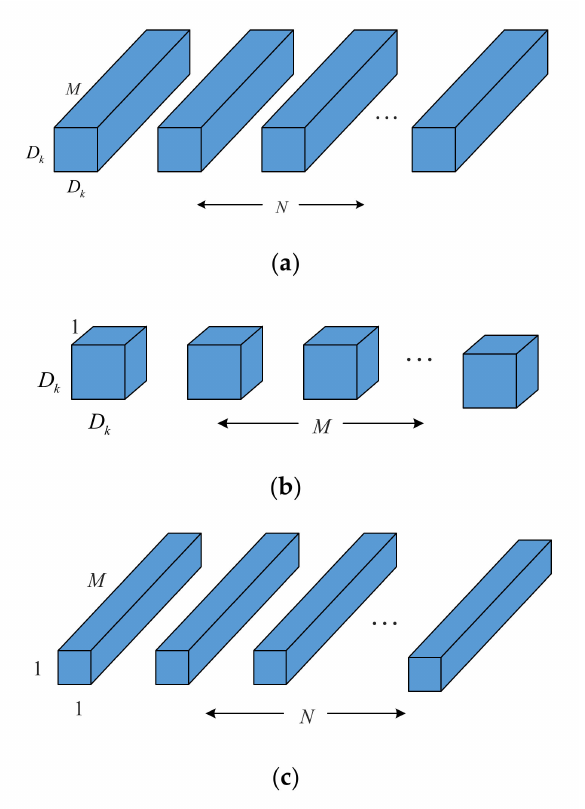
Figure 2. Standard convolution and depth detachable convolution. ( a ) Standard convolution filters. ( b ) Depth convolution. ( c ) 1 × 1